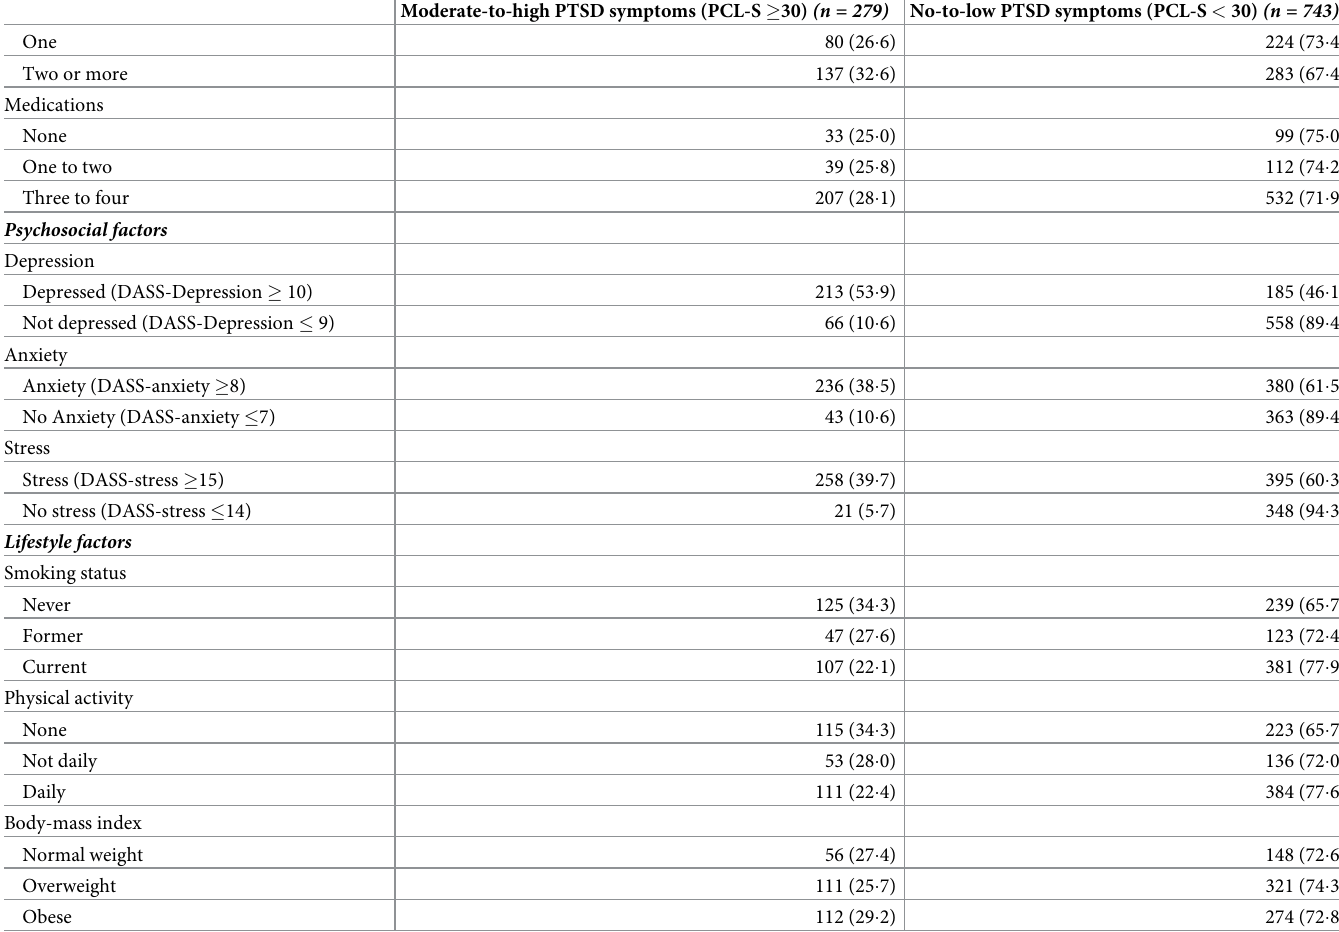
DASS = Depression, Anxiety, Stress Scale. Physical activity defined as the number of days of physical activity for at least 30 minutes per